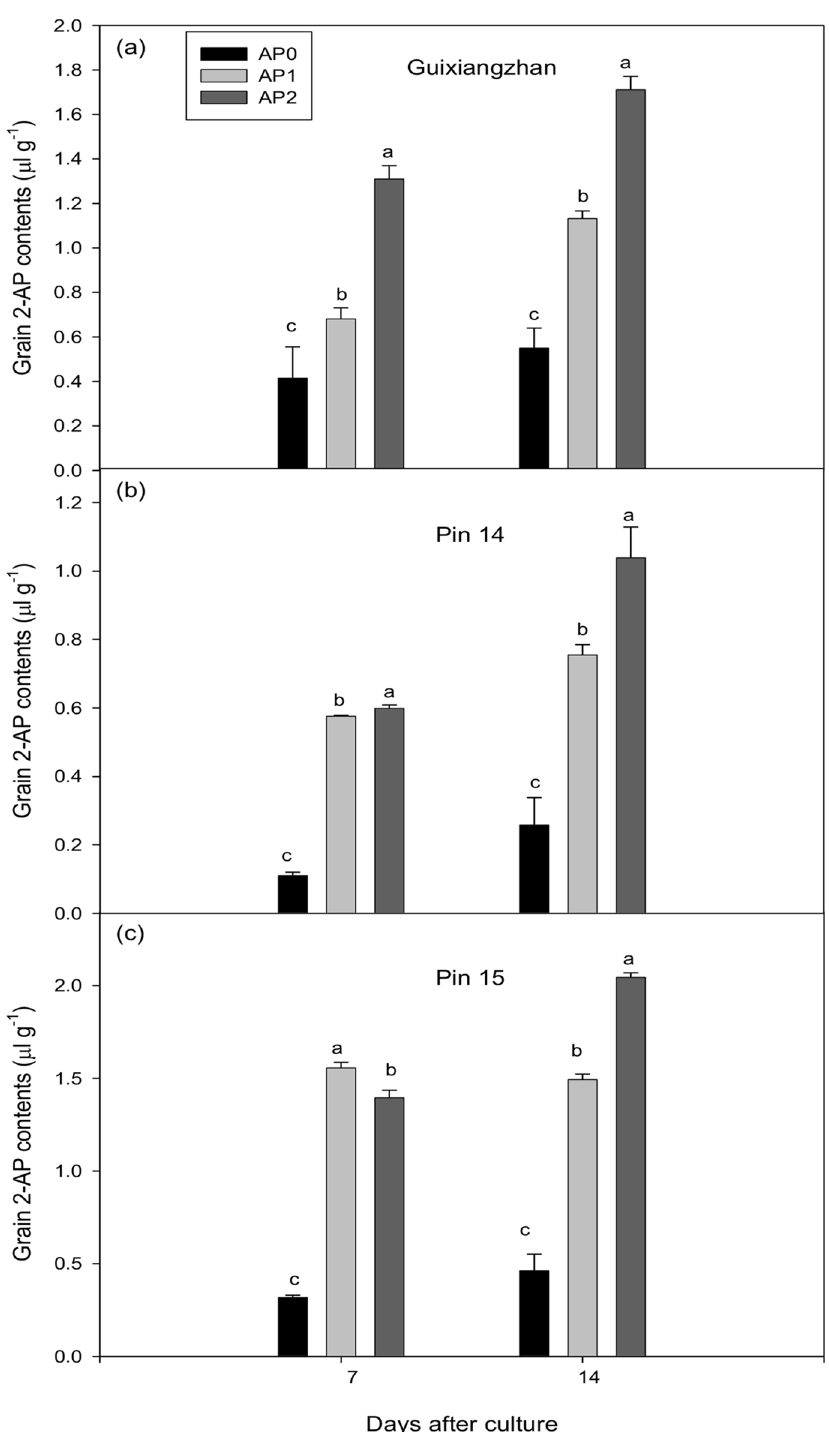
Fig 1. Effect of 2-AP supplementation on accumulation of 2-AP concentrations ( μ l g -1 ) in grains of detached aromatic rice panicles in vitro . Means in the same harvested stage by different lower case letters for the same variety differ significantly at P (cid:2) 0.05 by DMR test. Capped bars above means represent S.E. of three replicates.